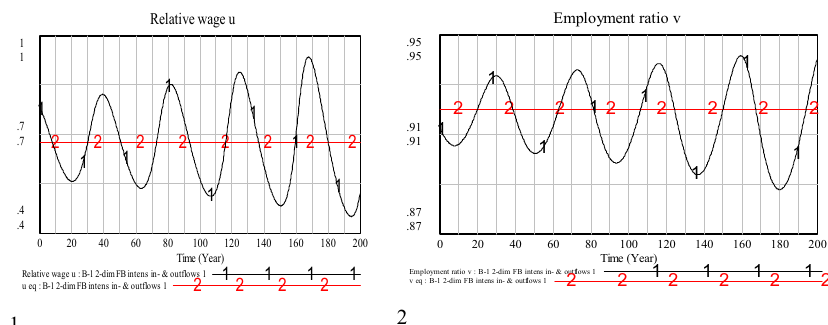
Fig. 3 Divergent fluctuations in B-1 around the stationary state (unstable focus) E p ; panel 1—relative wage u (1) against the stationary magnitude u p (2), years 0–200, panel 2—employment ratio v (1) against the stationary magnitude v p (2), years 0–200